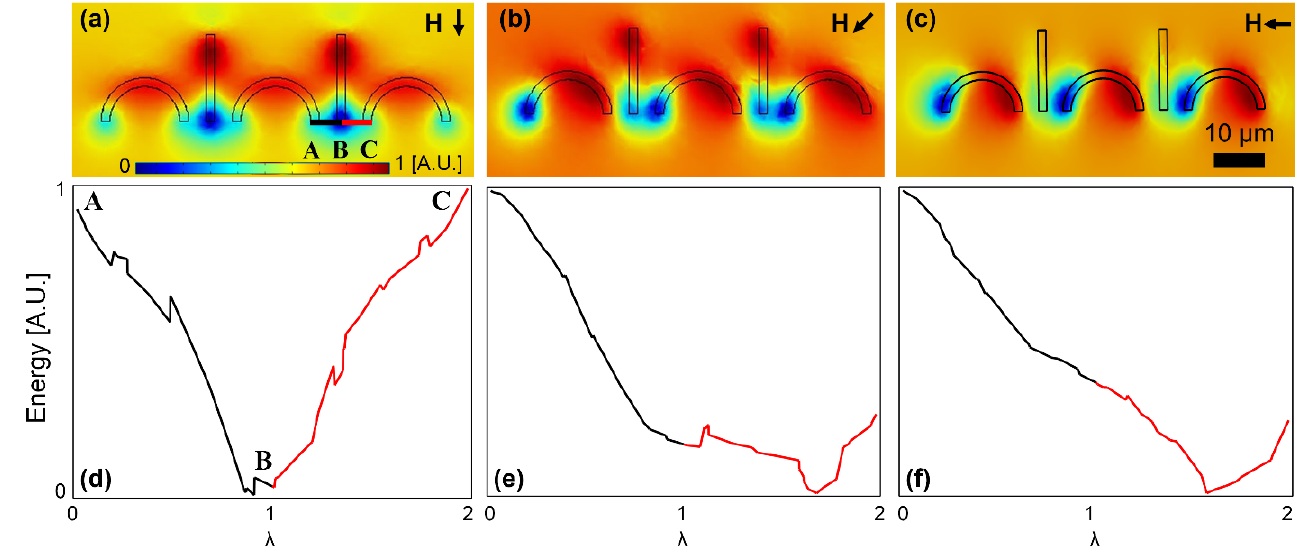
Figure 5. The particle transport from the I bar tip to the next C-shaped magnet is studied. ( a – c ) The potential energy distributions for three sequential magnetic field directions are illustrated. ( d – f ) The energies along the lines AB and BC (see ( a )) for the field directions of ( a – c ) are plotted in ( d – f ), respectively. The small black arrows stand for the magnetic field directions. The field is rotating clockwise, and the steps ( a – c ) are 45°. The energies are plotted at the center of a particle with a radius of 2.5 µm. The blue and red areas indicate the regions with low and high potential energies, respectively.